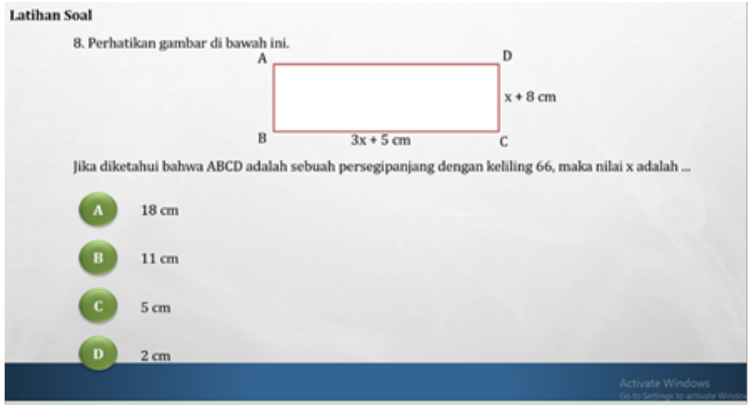
Fig. 5. Computer display of the drilling